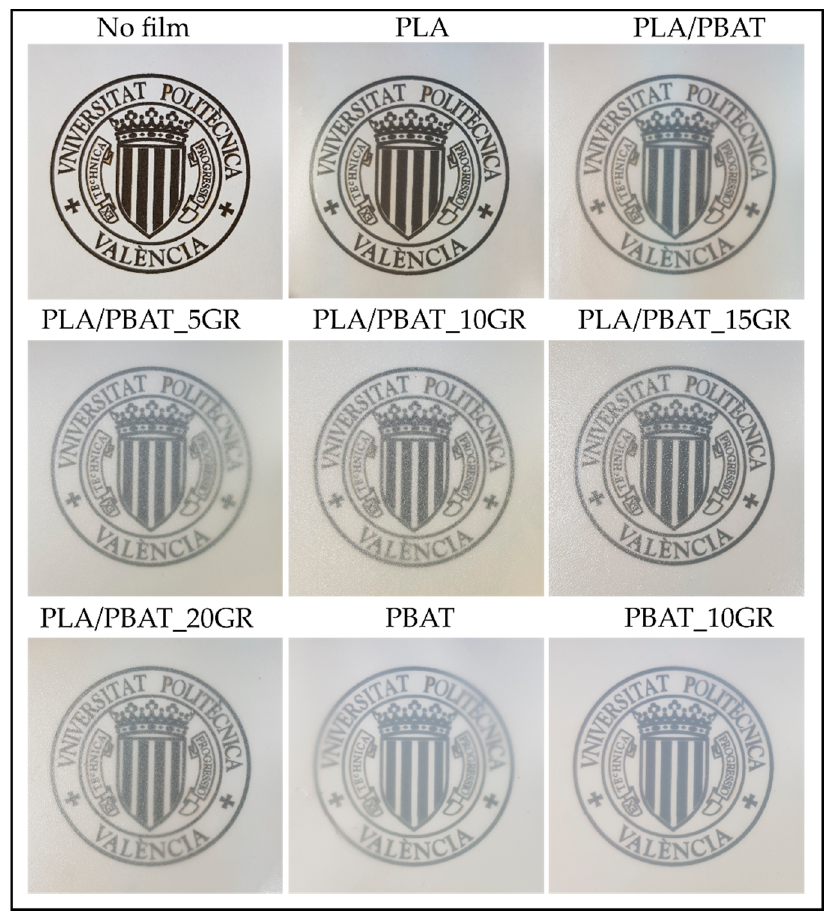
Figure 1. The visual appearance of PLA, PBAT, PBAT_10GR, PLA/PBAT, and PLA/PBAT with 5, 10, 15, and 20 phr GR resin films.